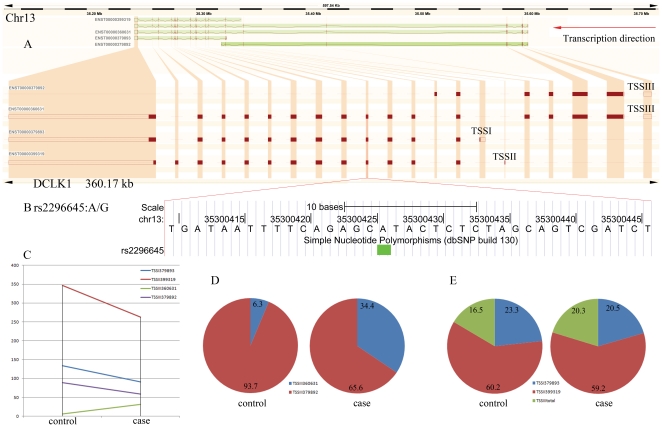
Alternative splicing, promoter usage, and SNP rs2296645 for the DCLK1 gene.(A) DCLK1 transcriptional isoforms ENST379892, ENST360631, ENST379893, and ENST399319 are detected in both schizophrenia subjects and controls. ENST379892 and ENST360631 have the same transcription start site TSSIII; ENST379893 and ENST399319 are initiated at TSSI and TSSII, respectively. (B) The location and nucleotide composition of the SNP rs2296645 in the DCLK1 gene. (C) Altered expression levels of the 4 isoforms of DCLK1 between schizophrenia subjects and controls. (D) Relative changes of the abundance of ENST360631 and ENST379892 from TSSIII between cases and controls. Numbers indicate the percentage of the isoform. (E) Increased usage of TSSIII and decreased usage in TSSI in the DCLK1 gene in schizophrenia subjects compared to controls. Numbers indicate the percentage of the promoter usage.